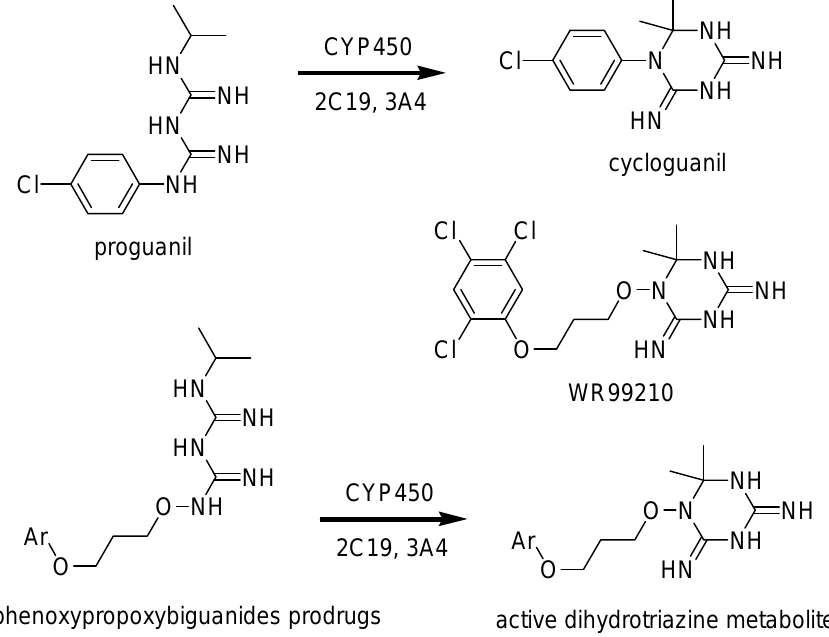
Figure 26. Chemical structures of proguanil, cycloguanil, WR99210, phenoxypropoxy- biguanides prodrugs and their active